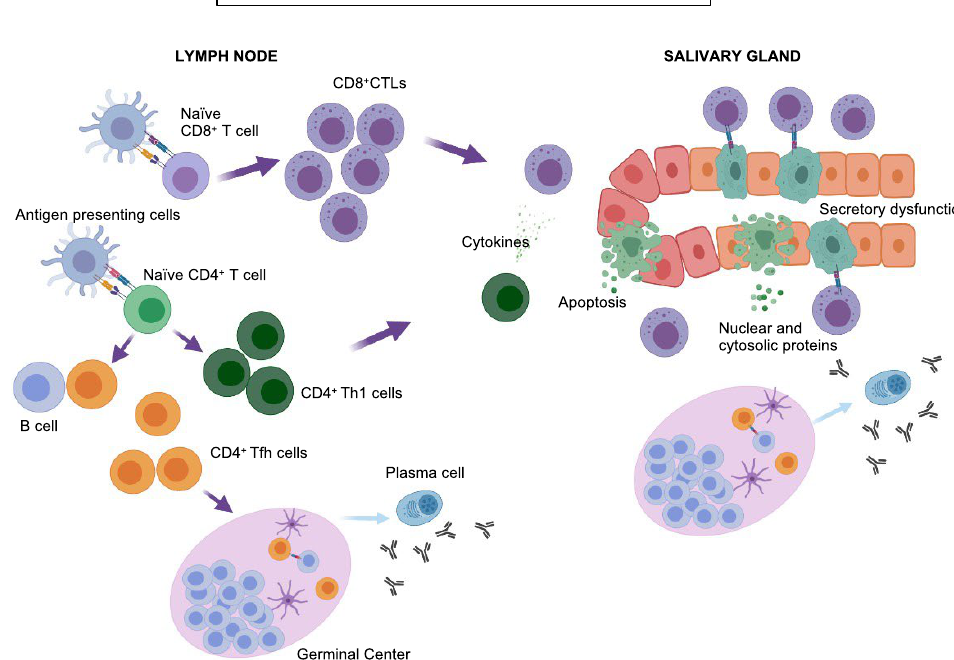
Figure 6. Schematic model for the pathogenesis of SS. Infiltration of tissues by Th1 CD4 + helper T cells and CD8 + T cells promotes inflammation, higher levels of Fas expression on epithelial (ductal/acinar) cells and CD8 + T cell mediated killing of acinar and ductal cell, resulting in irreversible secretory dysfunction. The antigenic targets of these CD8 + T cells are not known. The release of the contents of apoptotic cells including Ro/SS-A and La/SS-B and Tfh cells may help differentiation of B cells to plasma cells which produce antibodies to these